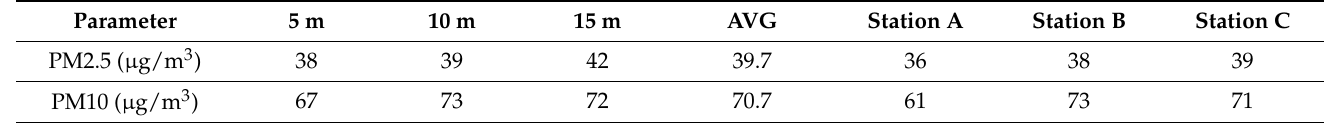
Table 4. Flight measurement data at three altitudes and data from national monitoring stations.